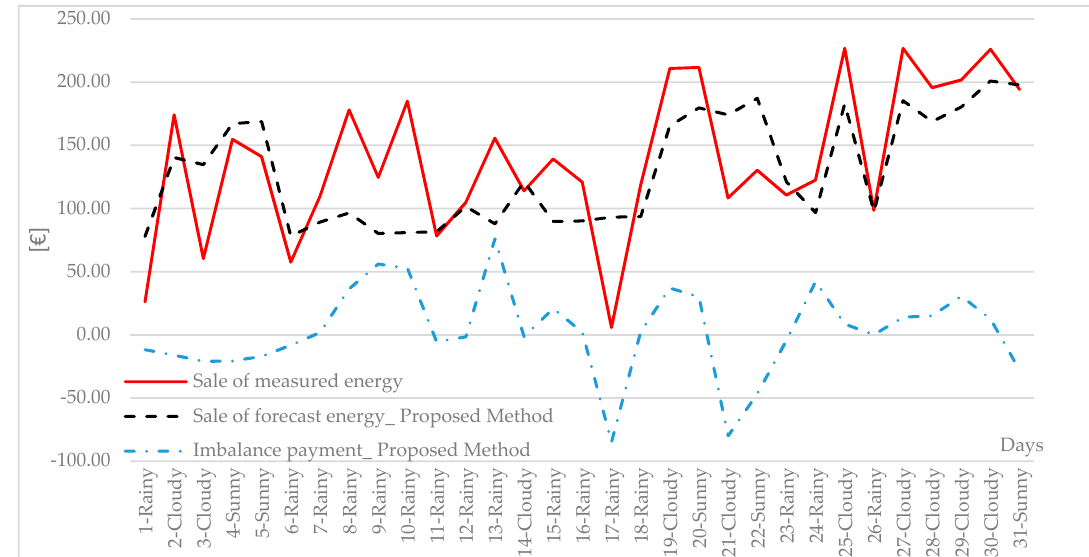
Figure 9. Economic evaluations: comparison between the sale of measured energy and the sale of foreseen energy; imbalance costs.